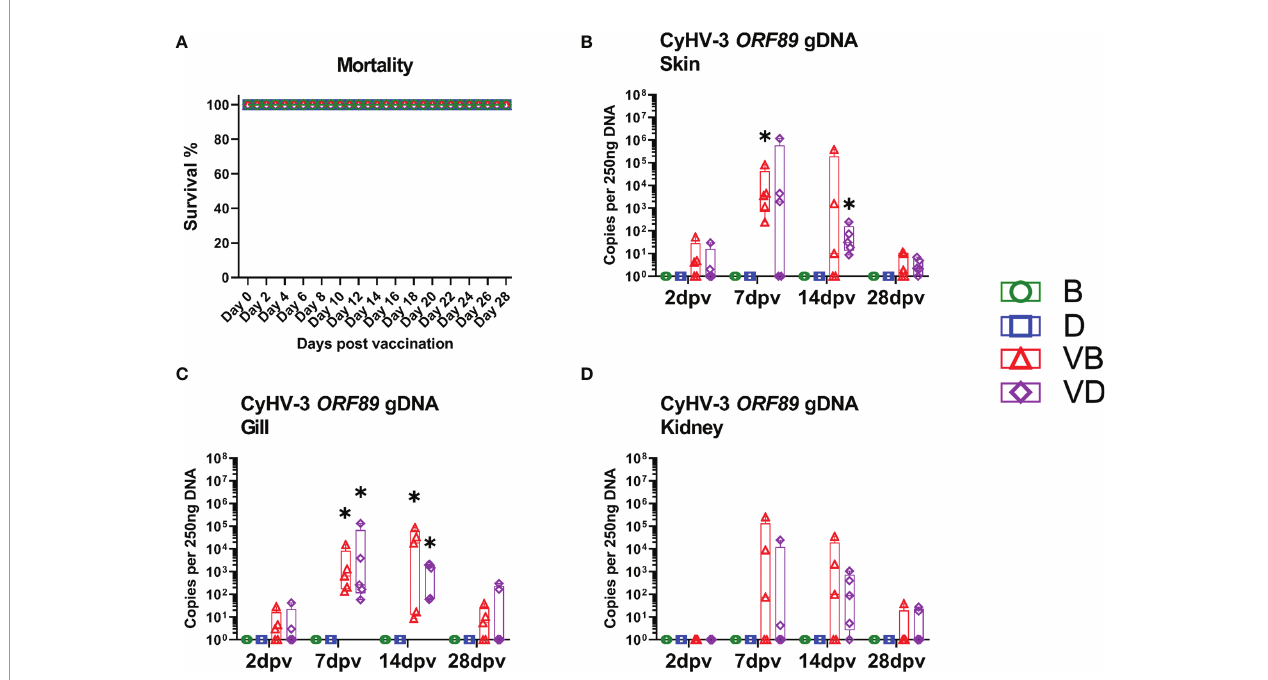
FIGURE 2 | Mortality and virus load after the vaccination with KHV-T D DUT/TK. (A) Approximated mortality during vaccination. (B) Virus load in the skin collected 2 days post vaccination (dpv), 7 dpv, 14 dpv, 28 dpv. (C) Virus load in the gills. (D) Virus load in the kidney. The description of experimental groups: B – BSA non- vaccinated, D – defensins non-vaccinated, VB - BSA vaccinated, VD – defensins vaccinated. The results are presented as 25%-75% box plots with min. and max. values as whiskers with indication of all data points. The data are shown as virus genome copy per 250 ng of extracted DNA. * indicates statistical signi fi cant difference to non-vaccinated controls at p < 0.05. Statistical analysis was performed with two-way ANOVA with multiple comparisons test performed with the Holm- Sidak